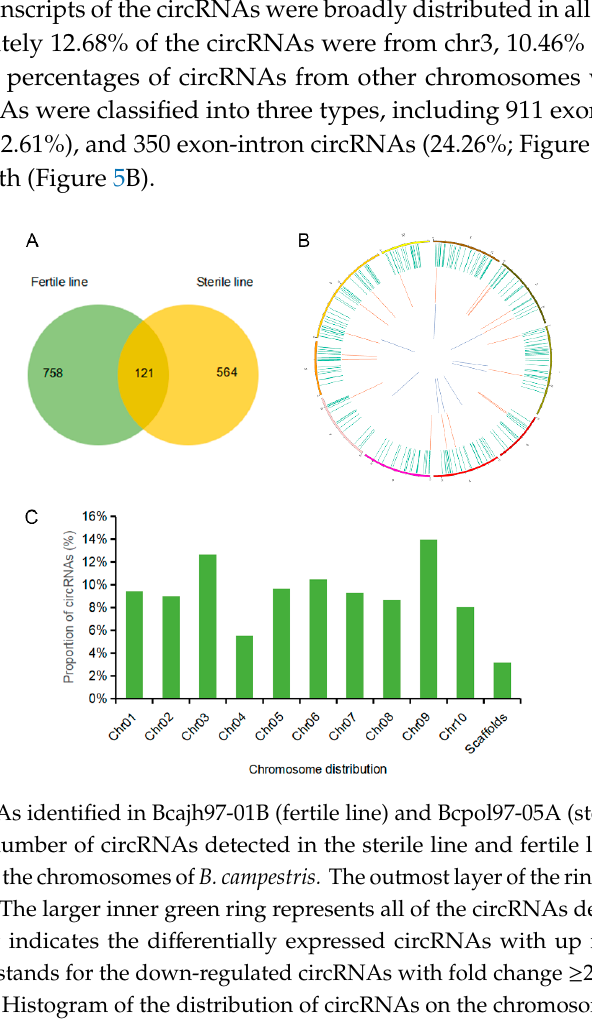
Figure 3. Anther transverse sections of Bcajh97-01B (fertile line) and Bcpol97-05A (sterile line) of Brassica campestris . Stage 1, pollen mother cell stage; Stage 2, meiosis stage; Stage 3, uninucleate stage;